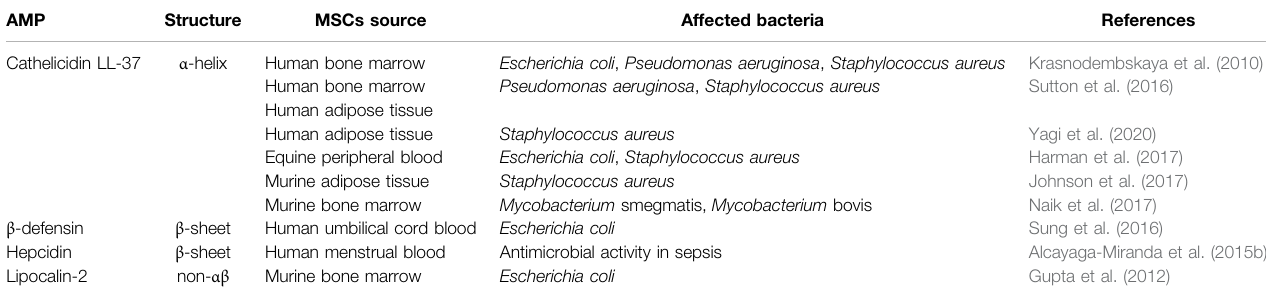
TABLE 1 | Characteristics of MSC-derived AMPs with their antimicrobial